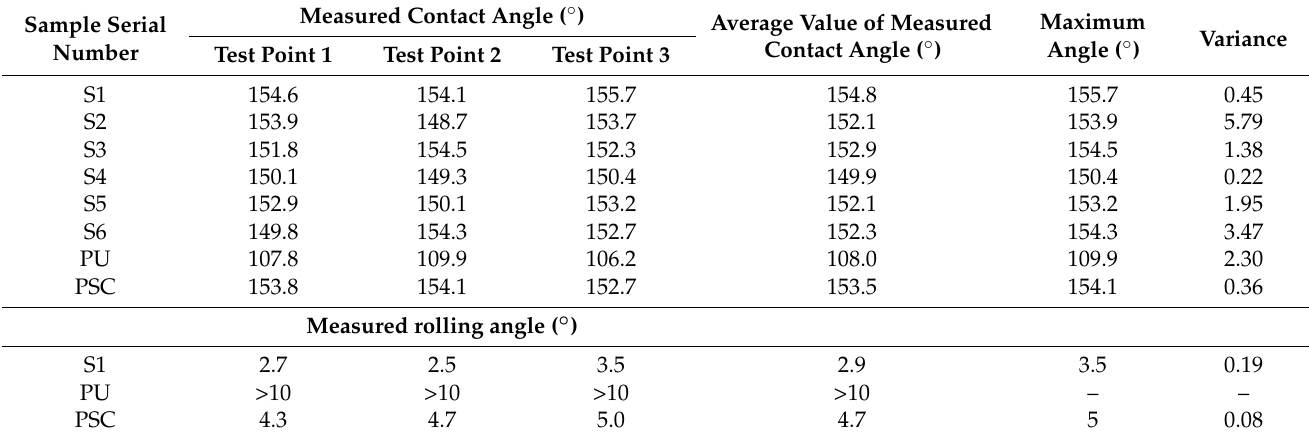
Table 2. Water contact angle and rolling angle test results.